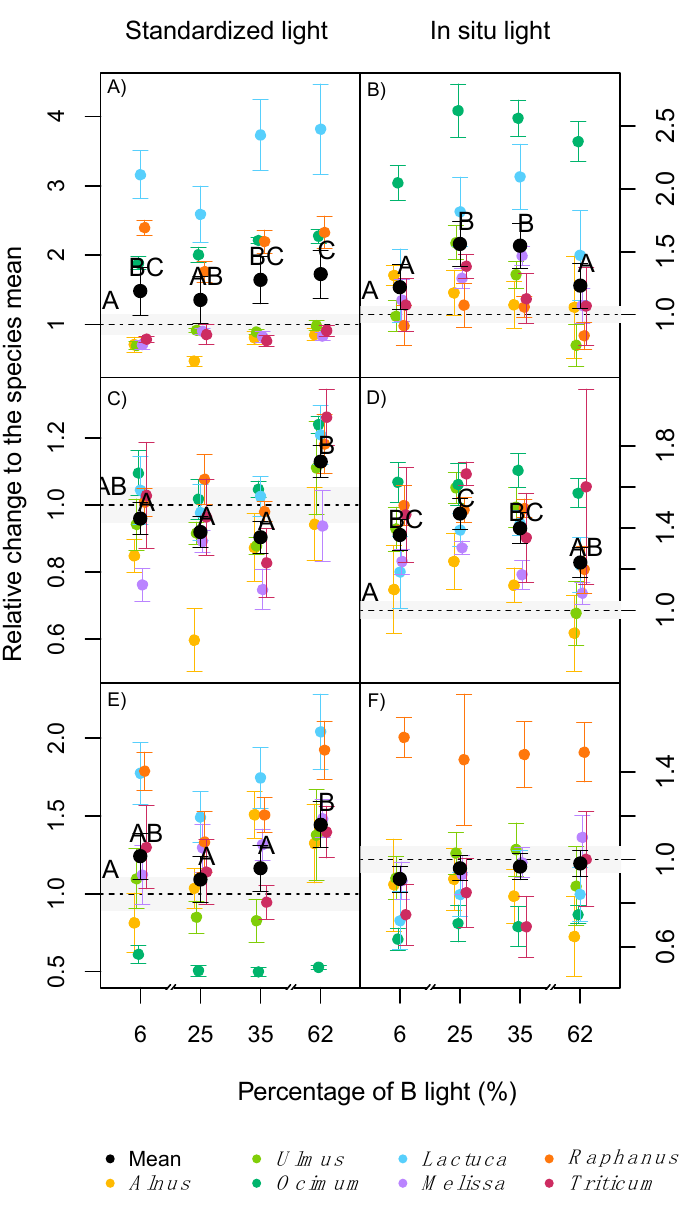
Figure 5. Fold change on maximum photosynthesis ( A max , A , B ), quantum yield of the CO 2 fixation curve ( α , C , D ) and dark respiration (DR, E , F ) relative to the average value of the field trial (dotted line). Values were measured with either a standard light with 70% B light and 30% R light (‘standardised light’) or the actual ‘in situ’ light (see methods for details). Coloured dots are the average of each species in both experiments runs (n=18), the black dots are the average values across all 7 species (n=126). Error bars indicate the standard errors. The grey area corresponds to the standard error of the field trial. Different letters indicate statistical difference between groups with experiment replicate and species as a random effect.